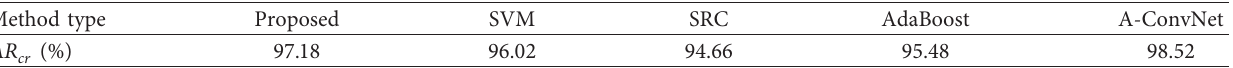
Table 5: Performance of methods with regard to configuration variance.